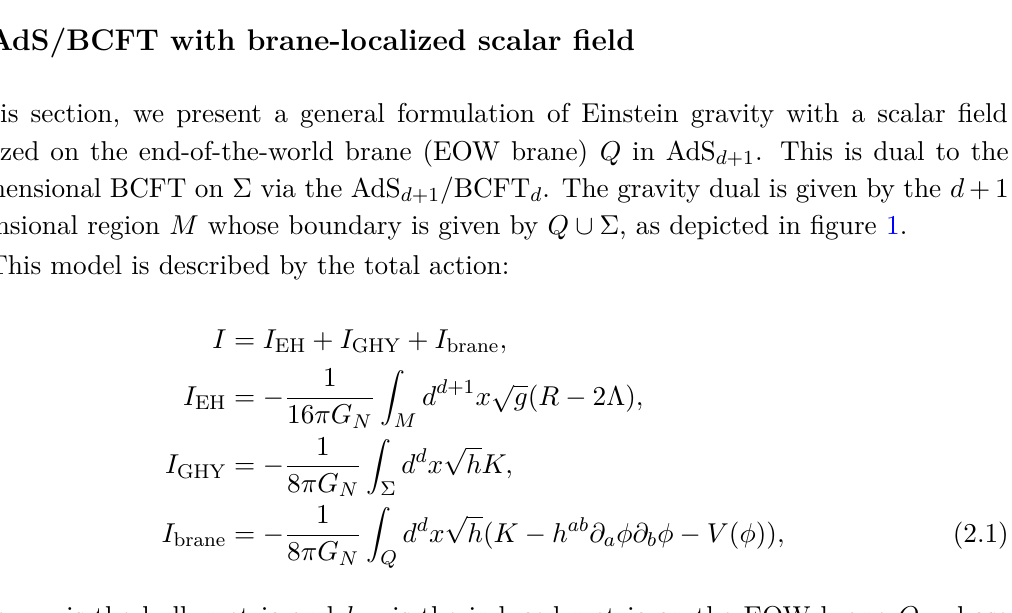
Figure 1 . A sketch of our setup of